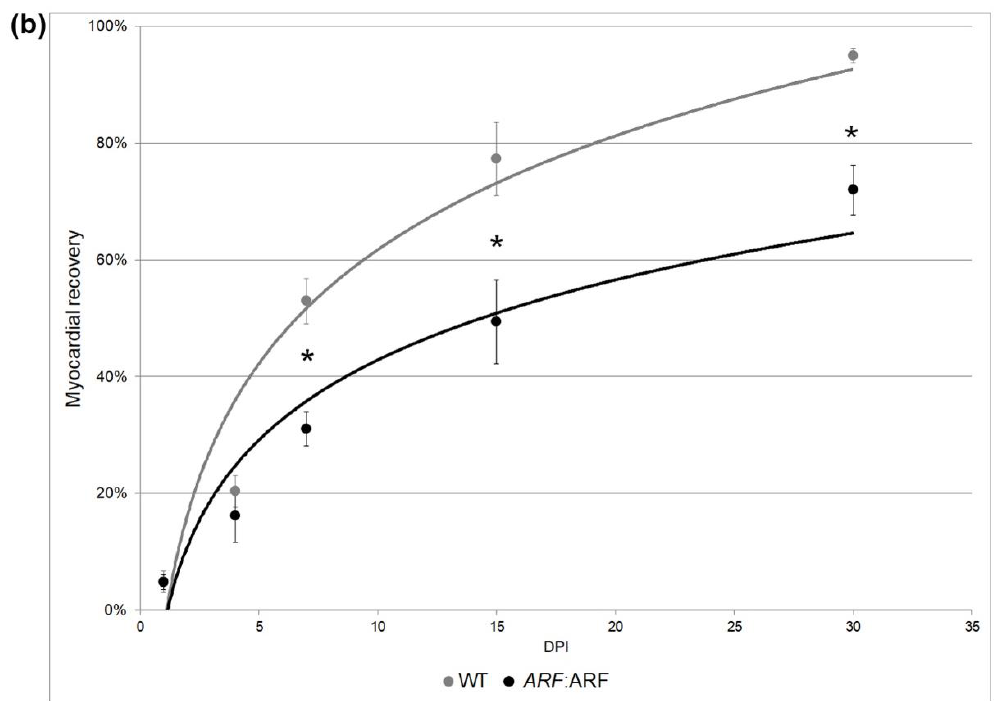
Figure 2. ARF expressed under control of the endogenous human ARF promoter in ARF :ARF fish suppresses cardiac regeneration over time. ( a ) AFOG and troponin staining of WT and ARF :ARF heart cryosections at 1, 7, 15, and 30 dpi. The dotted lines demarcate the injury site. Red stains are for fibrin. Blue stains are for collagen. Brown stains are for muscle. Green stains are for troponin. ( b ) Myocardial recovery measured by troponin infiltration into the injury site. Infiltration quantified by imaging software shows decreased troponin in the injury site of ARF :ARF fish compared to WT fish from 7 dpi onward. N = 49 hearts. The grey and black lines are logarithmic approximations of the WT and ARF :ARF heart recovery trends respectively. Results are shown as mean ± standard error. The * represents a statistically significant difference.